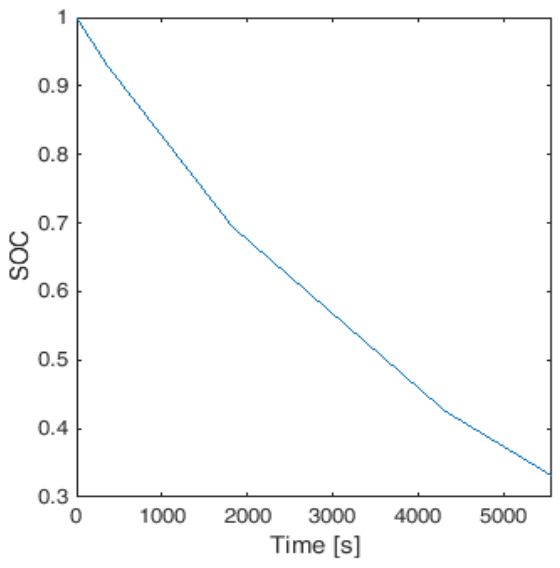
Figure 18. The battery pack SOC trend during a collection